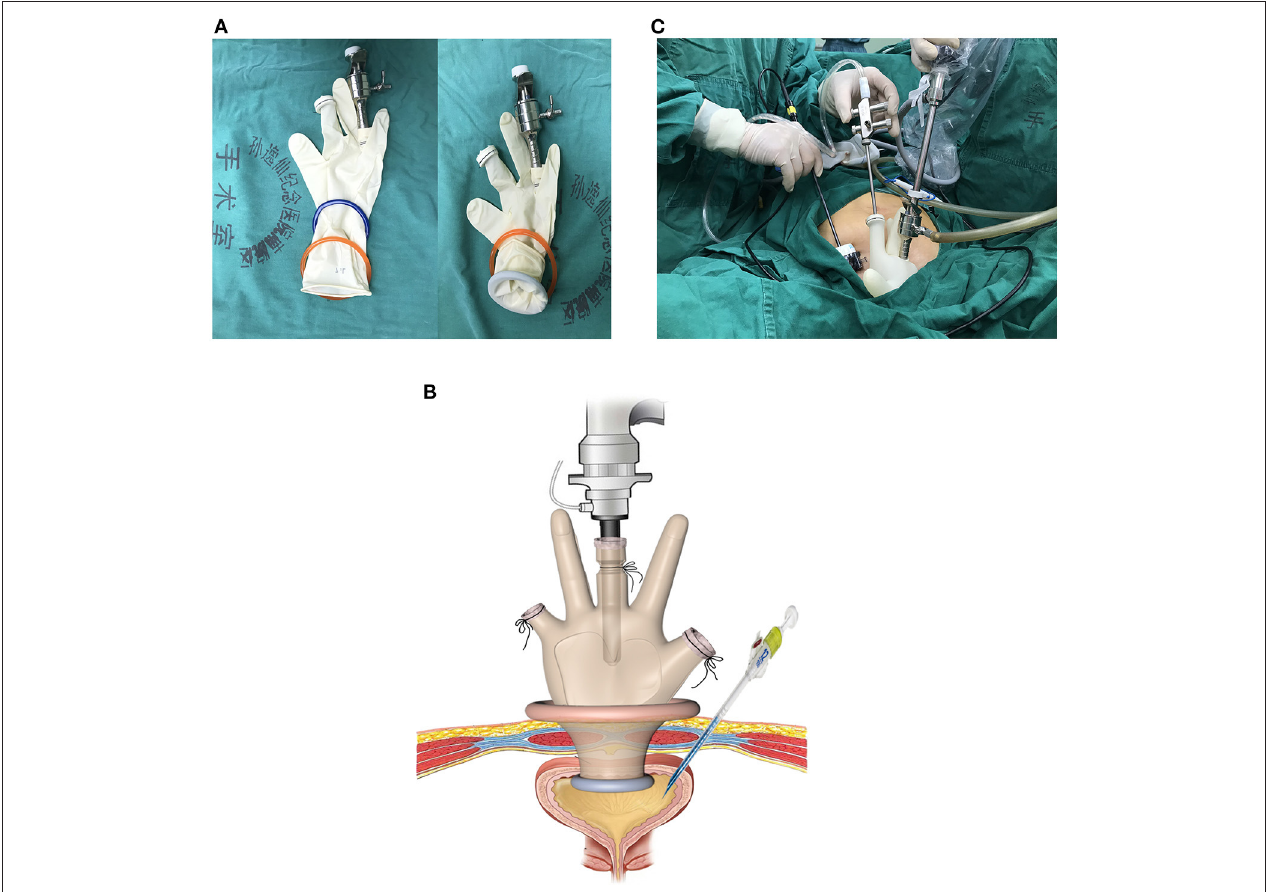
FIGURE 1 | Construction and placement of homemade single-port multi-channel access platform. (A) Two stretchable rubber rings and a surgical glove were used to construct the homemade multichannel single-port. (B,C) The inner ring was inserted through into the bladder cavity. The outer ring was kept outside the incision. At about 4cm right lateral to the incision, a 5-mm assistant trocar was